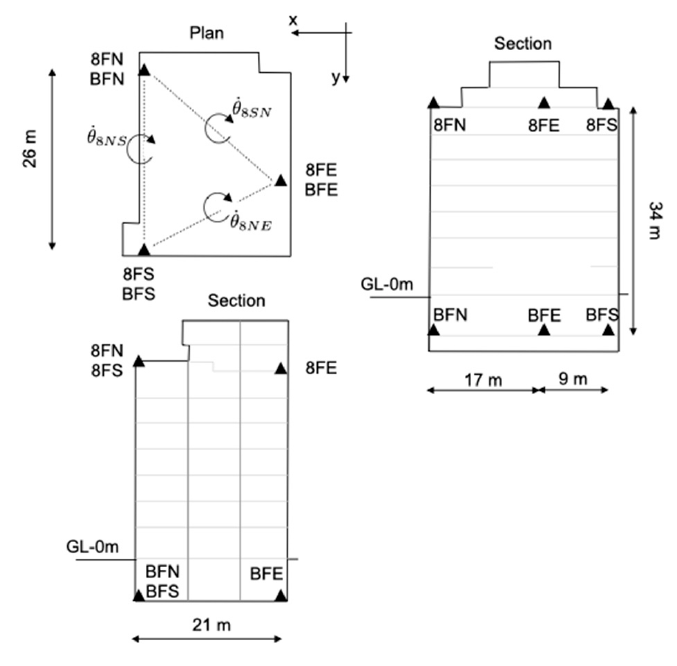
Figure 3. Schematic view of the ANX building and the positions of the sensors deployed at the top and bottom used in this study.